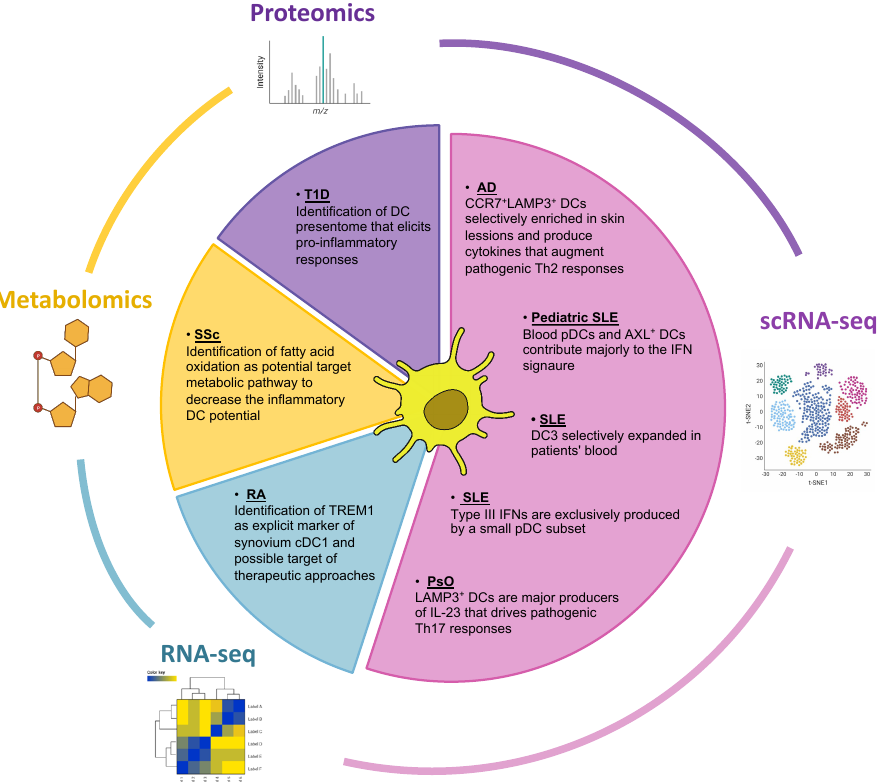
Figure 2. Multi-omics approaches utilized in IMIDs research focusing on dendritic cells. The Pie chart depicts omics technologies that have been used to study the contribution of dendritic cells in the pathology of IMIDs. Mainly scRNA-seq but also proteomic and metabolomic studies have highlighted dendritic cell subsets and inflammatory signatures that drive pathogenic responses in the disease spectrum of IMIDs. scRNA-seq, single cell RNA-sequencing; RA, Rheumatoid Arthritis; SLE, Systemic Lupus Erythematosus; T1D, Type I Diabetes; AD, Atopic Dermatitis; PsO, Psoriasis; Ssc, Systemic